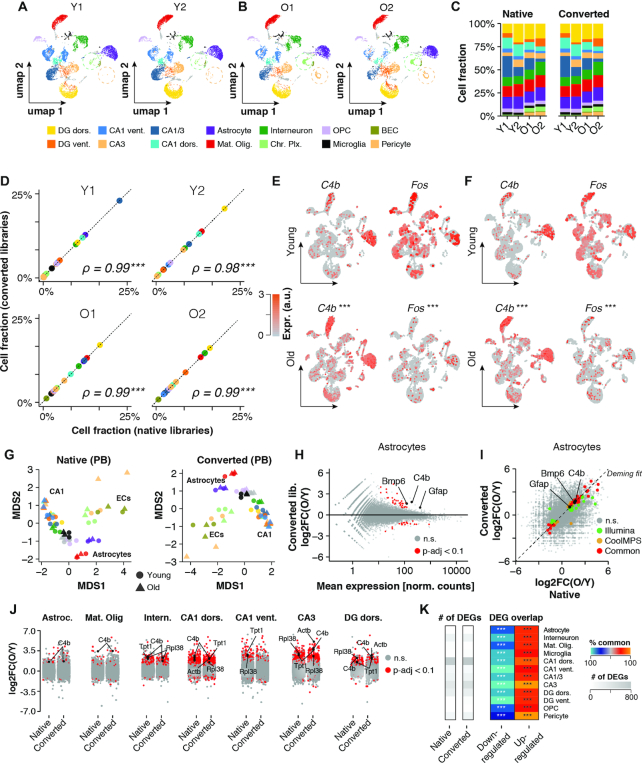
Inter- and intra-replicate differences are unaffected by conversion reaction. (A, B) UMAP representation of cells (CoolMPS-compatible dataset) with annotated cell types split by replicates across (A) young and (B) old. Circles highlight differential abundance of choroid plexus-derived cells and Pericytes. (C) Relative cell composition across replicates and datasets. (D) Sample-wise correlation of cell fractions as detected in the native and converted libraries dataset. ***P < 0.001, **P < 0.01, *P < 0.05, Spearman rank correlation test. (E, F) Expression levels of C4b and Fos per cell colored on UMAP as detected in (E) the native dataset and (F) the CoolMPS-compatible dataset, respectively. Expression of both genes changes significantly with age across all cells. ***Padj < 0.001, **Padj < 0.01, *Padj < 0.05, Two-sided Wilcoxon rank-sum test, adjusted for multiple testing. (G) Pseudobulk-level Multidimensional Scaling (MDS) plot for both datasets. Each point represents one cell population in a given sample. Points are colored by cell population and shaped by age. (H) Pseudobulk-level MA-plot for Astrocyte population (CoolMPS-compatible dataset). Genes showing differential expression (Padj < 0.1) between old and young are marked in red. *Padj < 0.1, two-sided Wald test, adjusted for multiple testing. (I) Cross-platform correlation of pseudobulk-level, gene-wise log2-transformed expression ratios between young and old samples. Detected DEGs (Padj < 0.1) common and distinct to either dataset are colored. (J) Distribution of pseudobulk-level gene-wise expression changes between old and young animals, resolved by cell population. Genes showing differential expression (Padj < 0.1) between old and young in given cell type are marked in red. (K) Total number of detected DEGs per cell population using either the native or converted libraries (grey heatmap) and per-cell population overlap of common DEGs relative to total DEGs, split by up- and down-regulated genes. % overlap is indicated by color scale. ***Padj < 0.001, **Padj < 0.01, *Padj < 0.05, two-sided Fisher's exact test, adjusted for multiple testing. Abbreviations: Y1, Y2, young male replicates 1 and 2; O1, O2, old male replicates 1 and 2; DG dors., granule neurons of dorsal dentate gyrus; DG vent., granule neurons of ventral dentate gyrus; CA1 dors., pyramidal neurons of dorsal CA1; CA1 vent., pyramidal neurons of ventral CA1; CA3 dors., pyramidal neurons of dorsal CA3; CA1/CA3 Neur., pyramidal neurons that could not be clearly allocated to CA1 and CA3; GABA interneuron, GABAergic interneurons; Mat. Oligos, mature oligodendrocytes; OPCs, oligodendrocyte precursors; MGs, microglia; Chor. Plx., choroid plexus cells; ECs, brain endothelial cells; Astroc., astrocytes; n.s., not statistically significant; a.u., arbitrary unit; obs./exp., observed over expected.